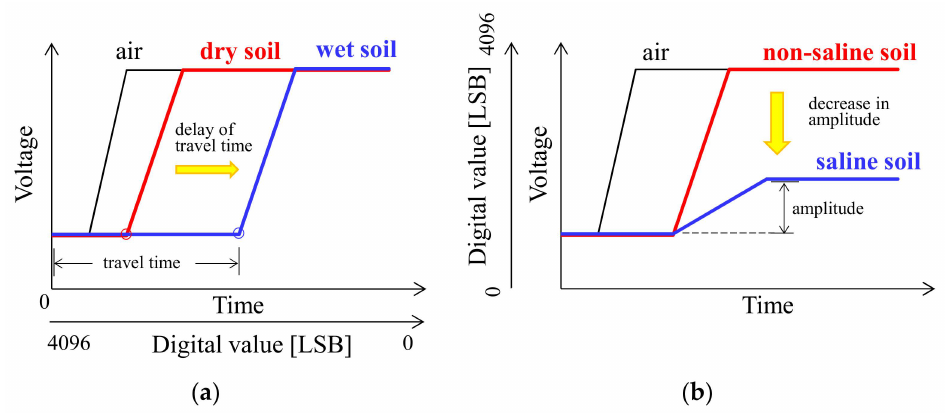
Figure 2. Time domain transmissiometry waveform analysis for ( a ) soil water content (dielectric constant) and ( b ) electrical